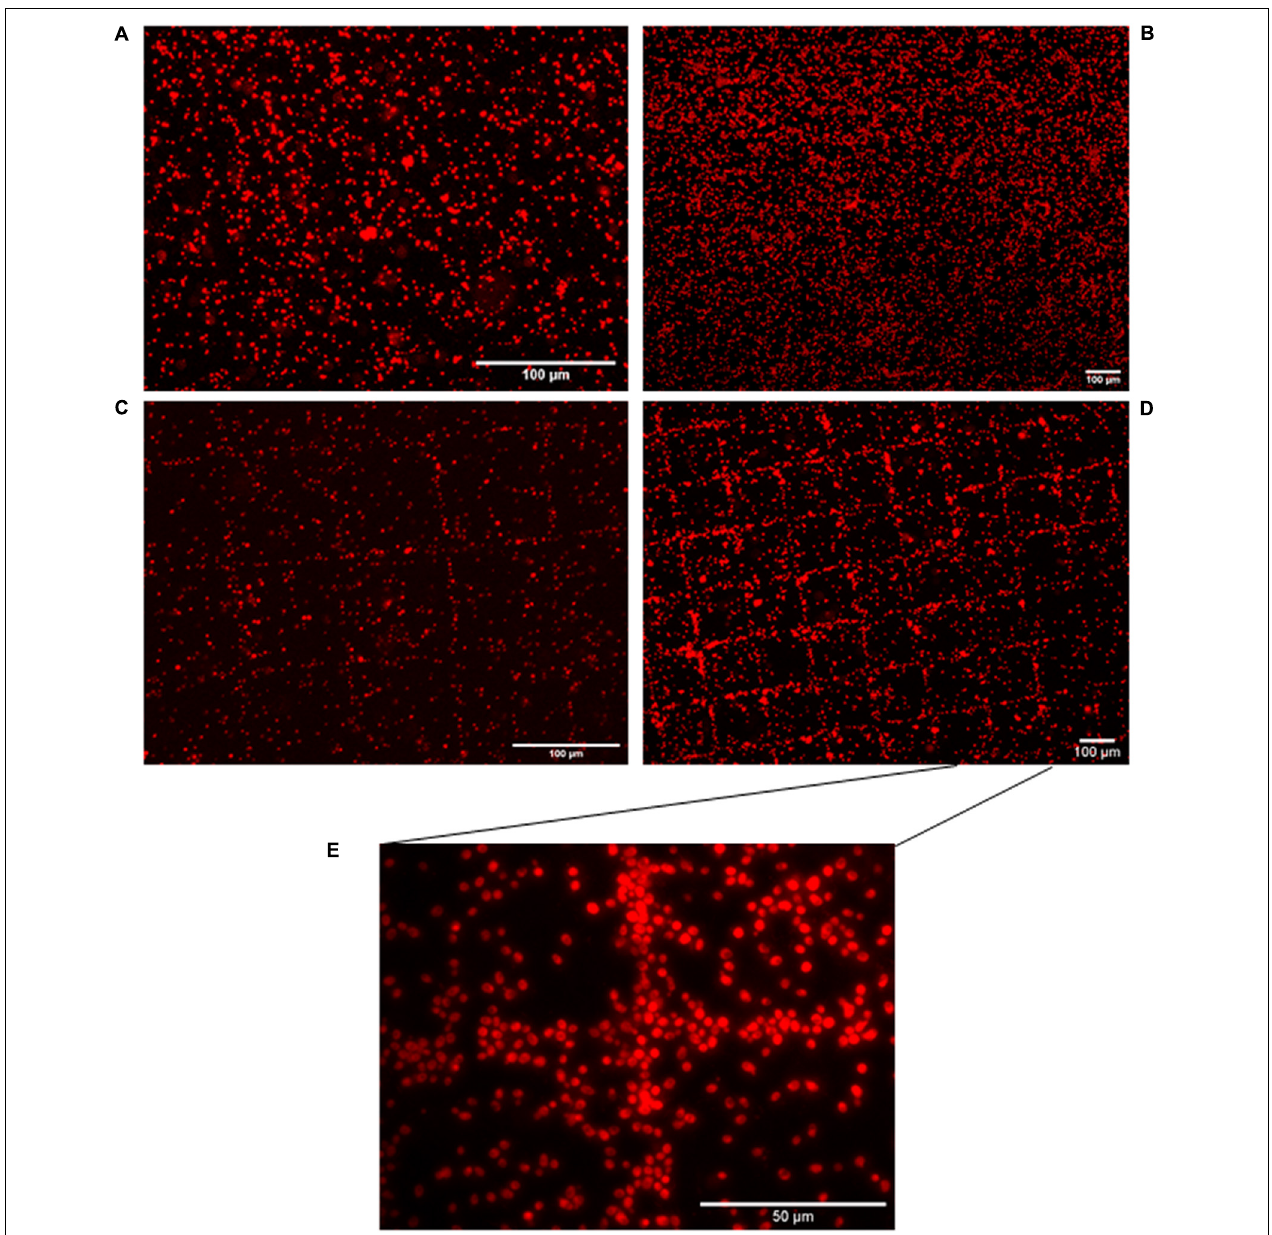
FIGURE 2 | Eukaryotic cell distribution patterns following HCR-MISH. Yeast cells from calibrated samples were subjected to complete treatment apart from incubation with superparamagnetic nanoparticles (10 × magnification) (A) . Yeast cells were in contact with just biotinylated probes (H1 and H2), in the absence of the initiator sequence (including the 18S probe) and then were placed on the micro-magnet array (10 × magnification) (B) . H1 probe was solely used, i.e., without H2, images show a few square patterns (20 × magnification) (C) . Complete treatment of HCR-MISH using both amplifiers and the specific probe 18S, the patterns obtained are far more distinct 10 × (D) . Same treatment as (D) , but at higher magnification, yeast cells can be individually distinguished: 50 × (E)